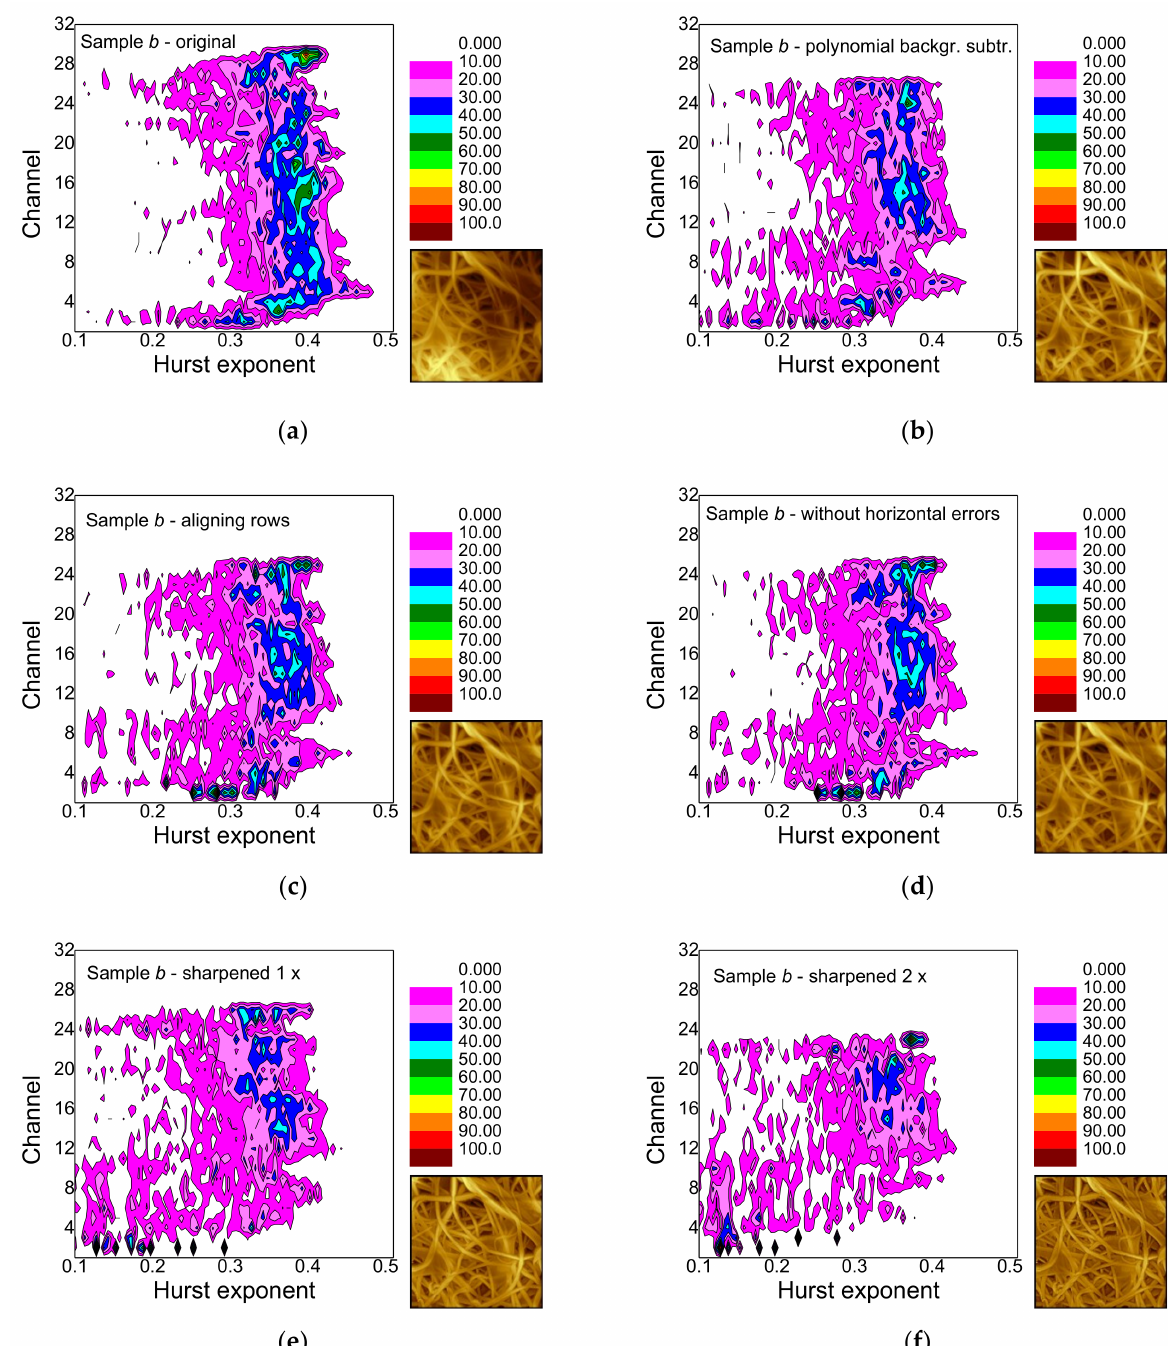
Figure 7. Gray-scale-resolved Hurst exponent distribution of sample b : ( a ) original; ( b ) after polynomial background subtraction; ( c ) after aligning rows; ( d ) after deleting horizontal errors; ( e ) after sharpening; ( f ) after sharpening